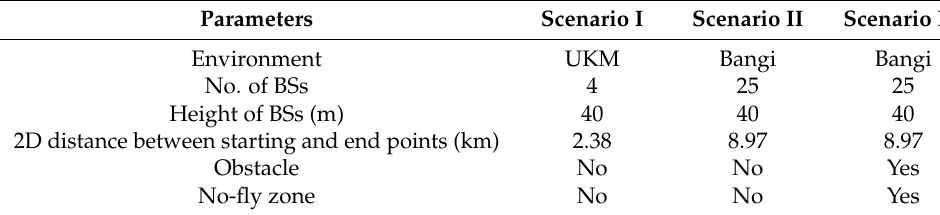
Table 2. Simulation parameters for modeling environments.